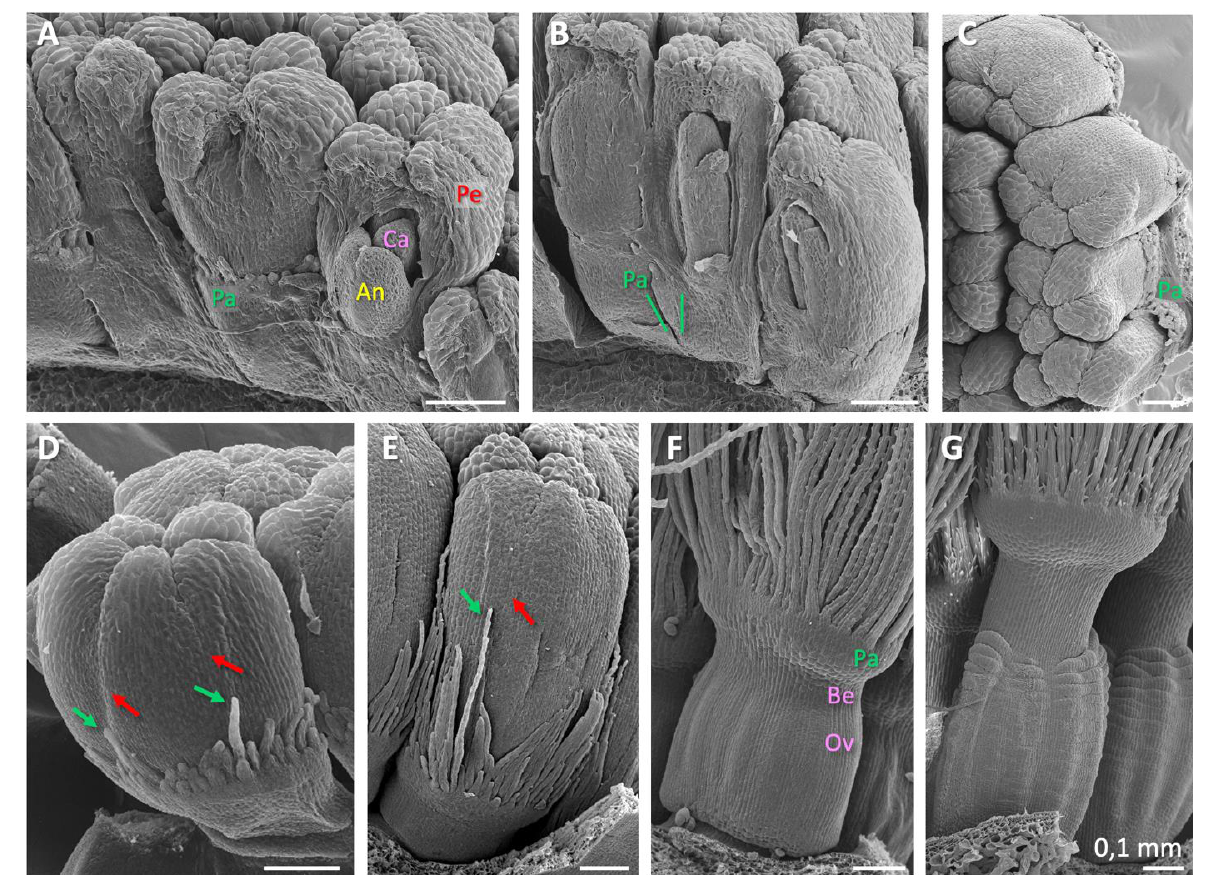
Figure 4. Scanning electron microscopy analysis of dandelion florets at young developmental stages. ( A ) Part of a capitulum of stage 5 (Table 1), with all floral organs formed, the petals covering the top of the florets, and the carpels lower than the anthers. Pa (green) = pappus; Pe (red) = petals; An (yellow) = anthers (stamen); Ca (pink) = carpels (pistil). ( B ) Some florets of stage 6 , showing organ elongation, and the carpels past the anthers. Green lines indicate part of the pappus ring initiation zone at the base of the petals, with a recently initiated pappus part on top. ( C ) The same florets of B viewed from the top, showing 2–3 rows of pappus parts separated from the corolla. ( D ) Floret of stage 5 , showing that pappus parts (green arrows) located at the petal fusion zones (red arrows), the alternipetal position where the sepals are expected (Figure 3), are ahead in growth. ( E ) Floret of stage 7 , confirming the growth advance of pappus parts located at the petal fusion zones, and showing relatively increased growth of the pappus parts; the ovary and beak start to pronounce. ( F ) Floret of stage 8 , with mature pappus parts on which scales have started to form, a pronounced pappus ring, and a clearly formed beak (Be) and ovary (Ov), with vertical lines on the fruit. ( G ) Fruit/Floret of stage 10 , showing the elongated beak and ovary and horizontal lines on fruit. © Bertie Joan van Heuven.